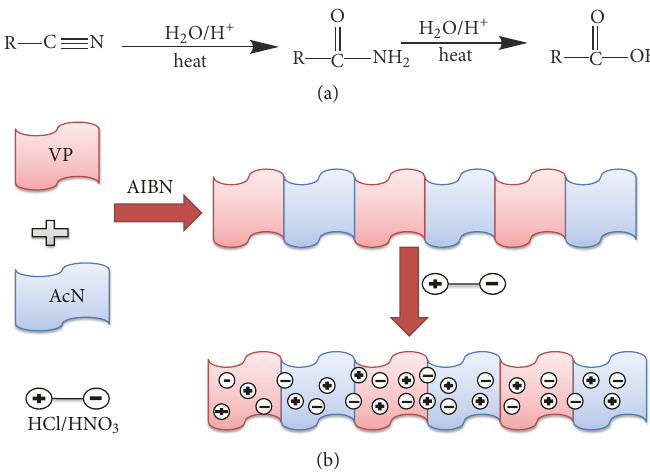
Figure 3: Diagrammatic representation of the series of reactions and the underlying mechanisms involved.